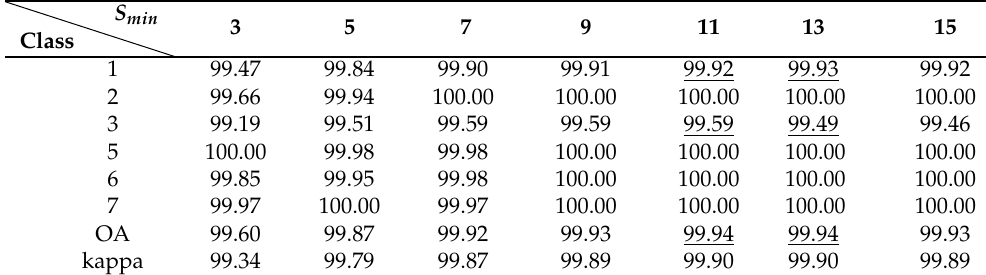
Table 2. Interpretation accuracies of different S min in saline areas dataset (%).